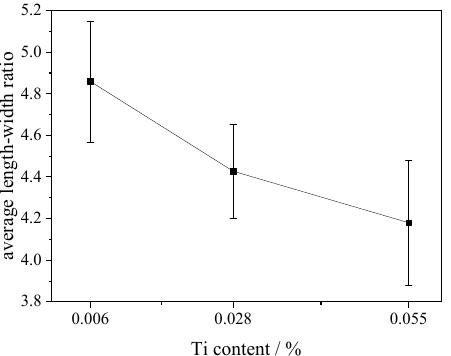
Figure 17. Variation of average length–width ratio of sulfides in steels with different compositions under rolling condition.